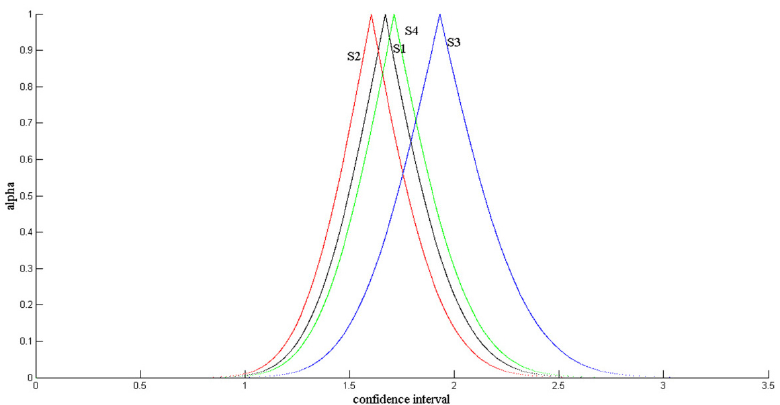
Fig. 1. Membership function of C pi for each